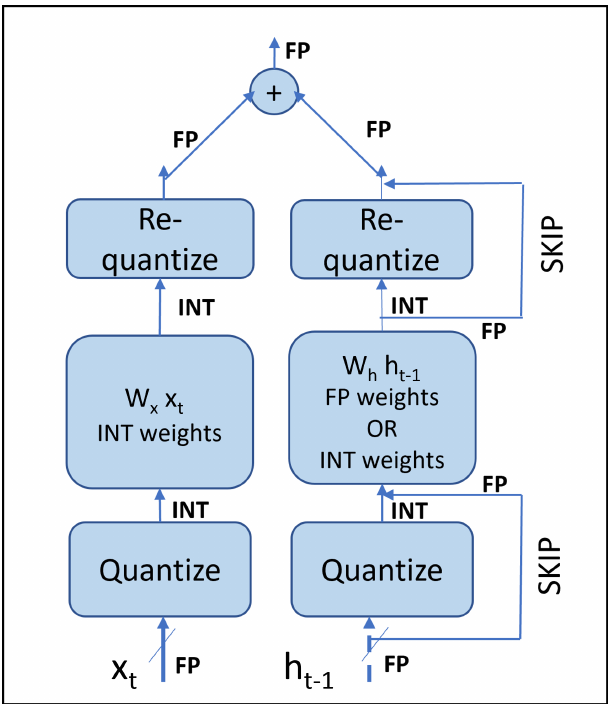
Figure 2. Integer matrix-to-vector ( M × V ) multiplication in a recurrent unit gate. Both of the input and the hidden state vectors are quantized to integer precision. Then, matrix-to-vector multiplication is applied between integer vectors and integer weights. Then, the vectors are re-quantized to a 16-bit fixed point. If the gate is configured to skip the recurrent path quantization. The hidden state vector is kept in a 16-bit fixed-point by skipping quantization; then it is multiplied with fixed point weights and requantization is